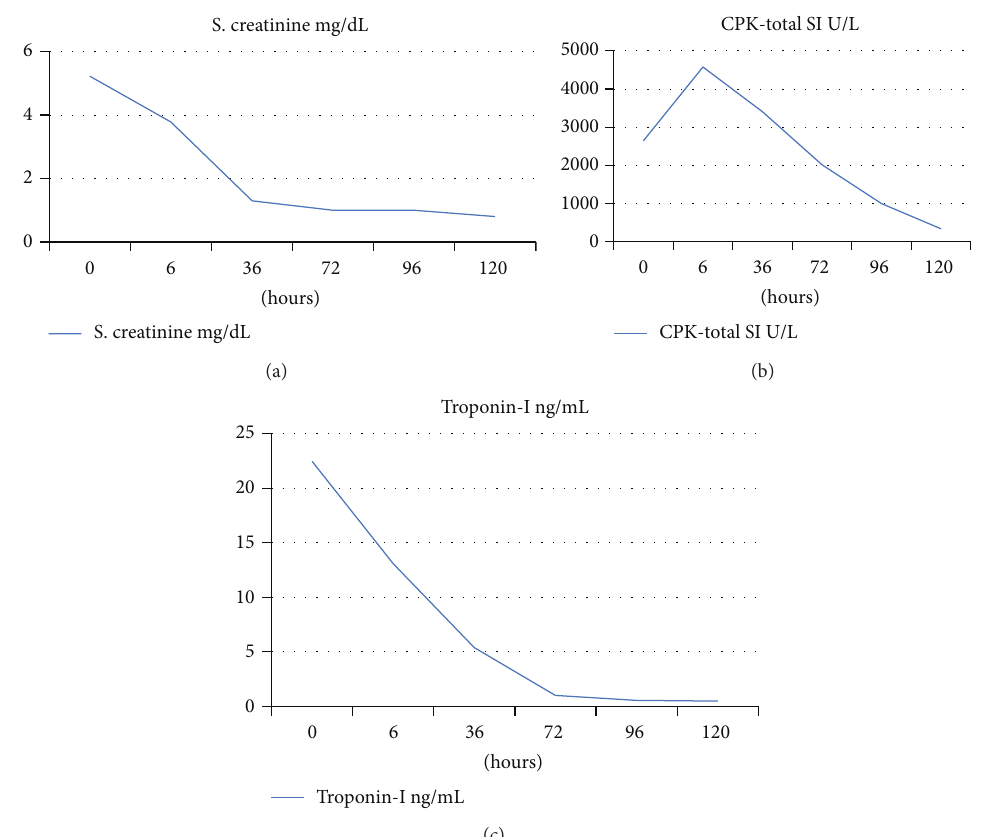
was high (290.1 mosmol/L) with urine/plasma osmolality ratio of 0.8 and urinary spot Na+ of 81 mmol/L. Urine analysis tested positive for pigmented casts. His serum creatinine phosphokinase (CPK) level was significantly high and has almost doubled after 6 hours (Table 1 and Figure 1(b)).